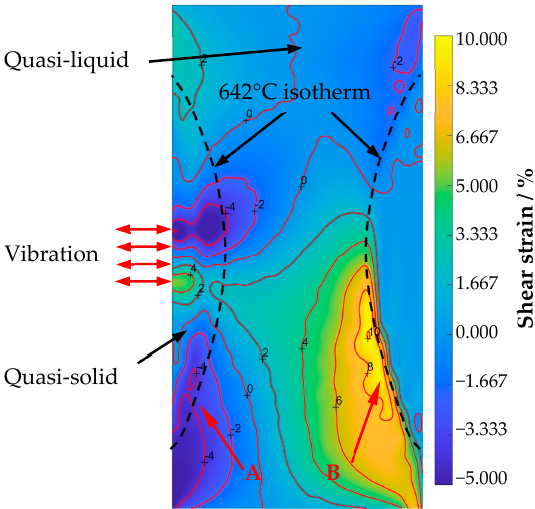
Figure 12. The shear strain of the feeding channel at 24% 𝑓 sc at 220 ms.